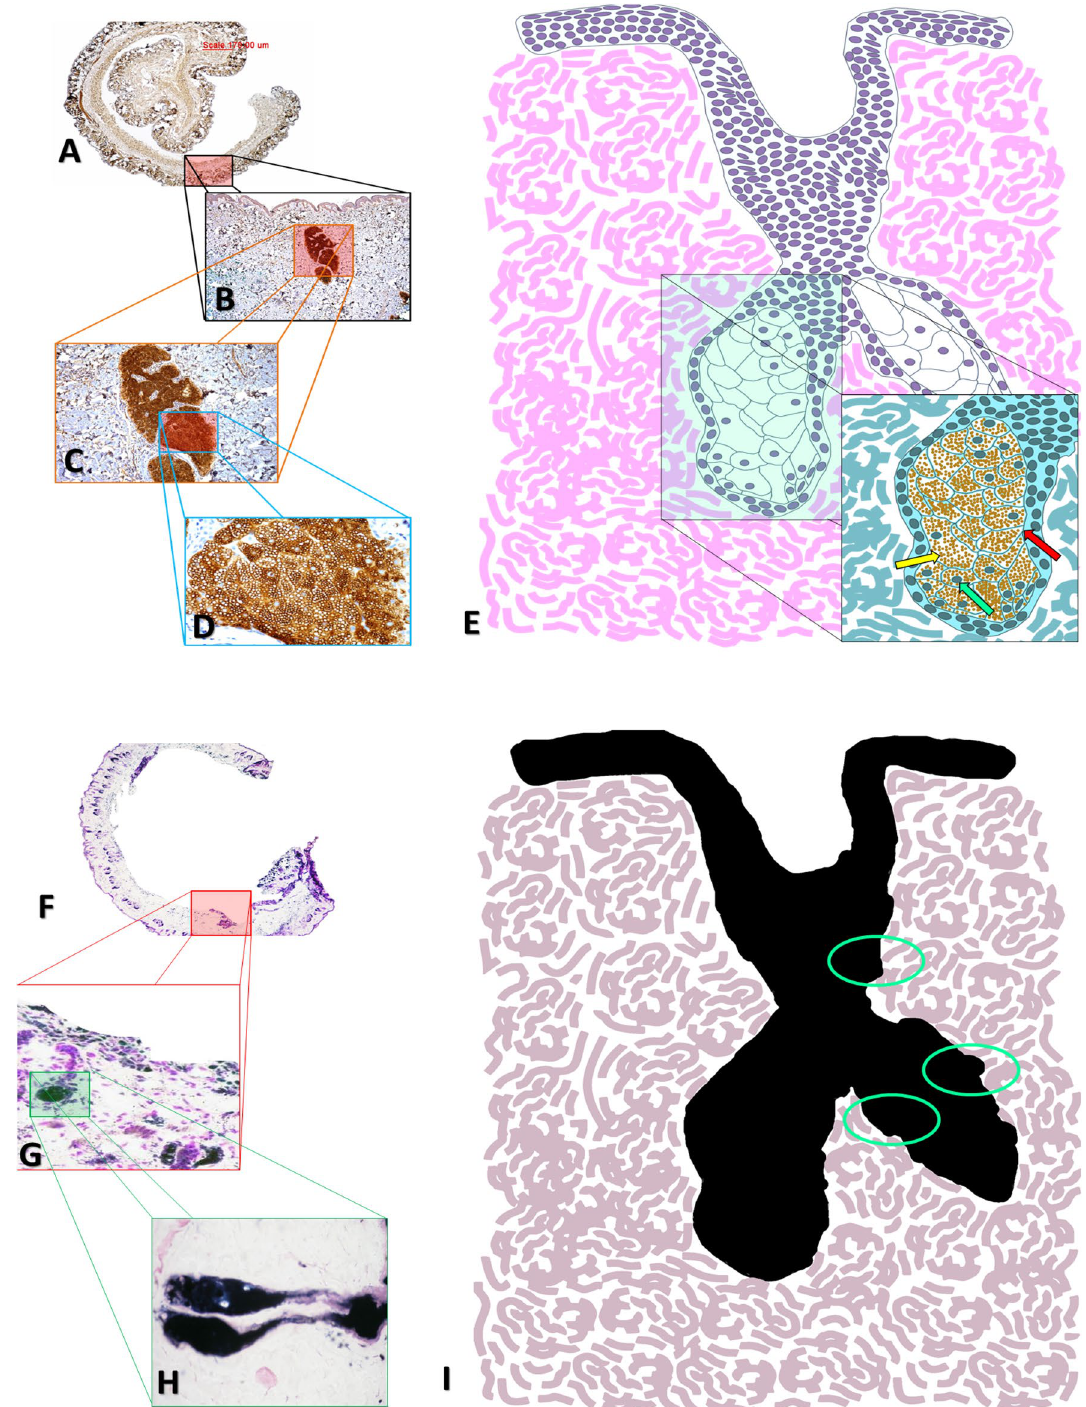
Figure 1. In ( A – D ) photomicrographs of mice tissues sections, evaluated in different enlargement in the microscopy, allowed us to observe how much the immunohistochemical technique by ADPH becomes essential, due to its sensitivity, to allow sebaceous differentiation in paraffin-embedded material, as demonstrated in the scheme represented in ( E ). In ( F – H ), we have photomicrographs of the sections of the mice’s frozen tissue stained with Sudan Black. Note the presence of black spots, provided by the labeling of the many lipids present in fresh tissue. This technique, when evaluated in a different objective, does not allow the sebaceous differentiation, as demonstrated in the scheme in ( I